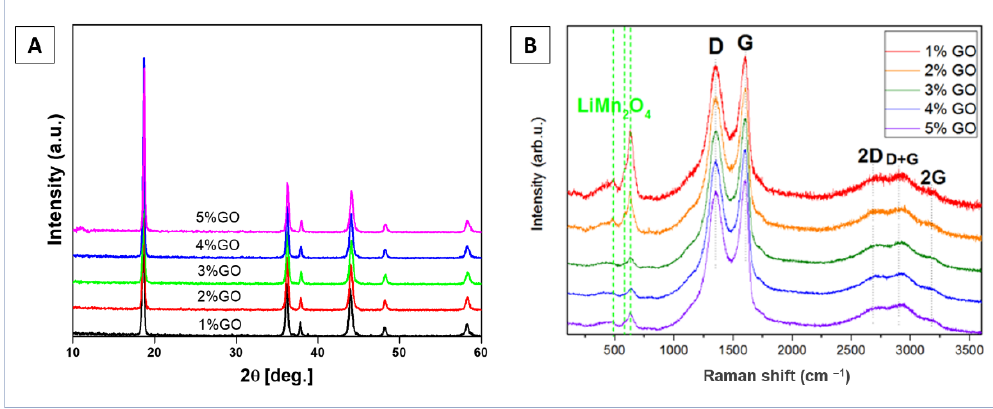
Figure 2. The XRD results ( A ) and Raman spectra ( B ) of LMO/1 – 5%wt. GO. Table 1. Average crystallite size, lattice parameter, and cell volume for LMO/1–5%wt. GO. Sample